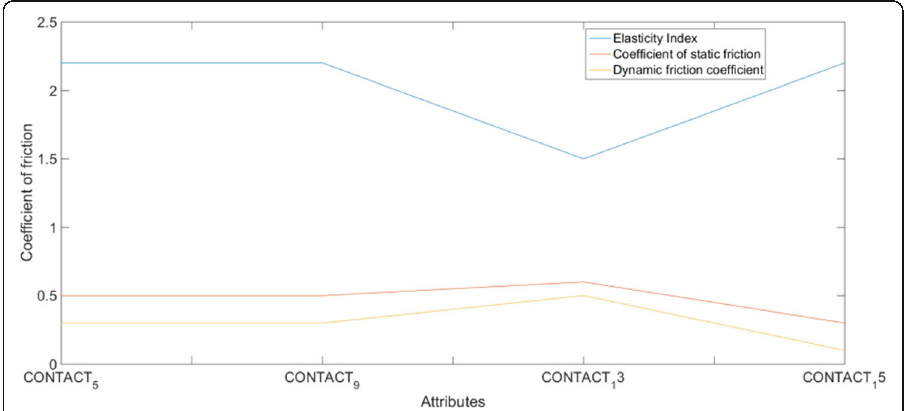
Fig. 2 Parameter values set by the